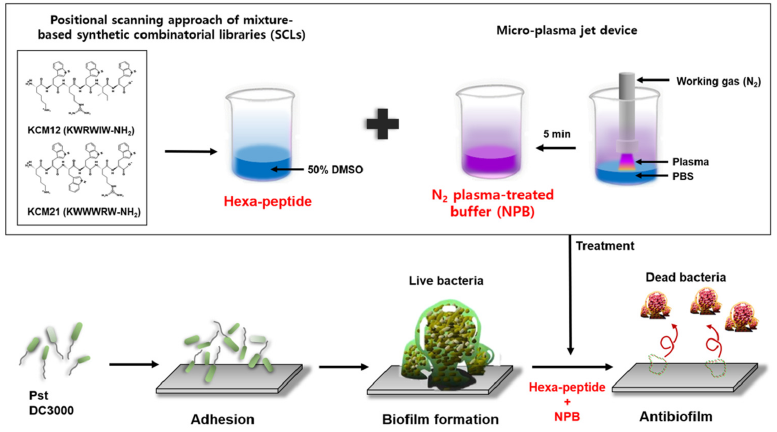
KCM21) and N 2 plasma-treated bu ff er (NPB), generation of Pst DC3000 as plant pathogenic bacterium, and enhanced antibiofilm e ff